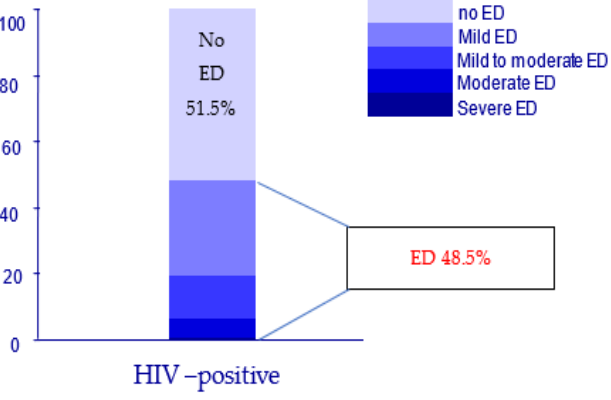
Figure 1. ED distribution by IIEF score categories in the IV-positive group. Regarding the age of the patients included, details are presented in Figures 2 and 3 with specific values in Table 3.